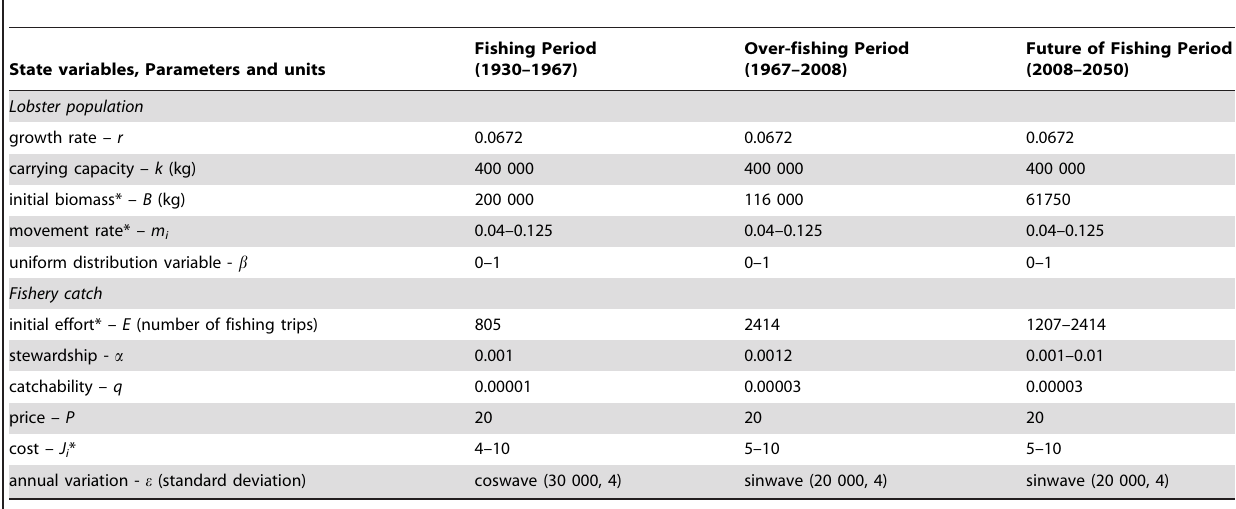
Table 1. Model parameters and initial conditions for the three periods; Fishing, Over-fishing and Future of fishing.